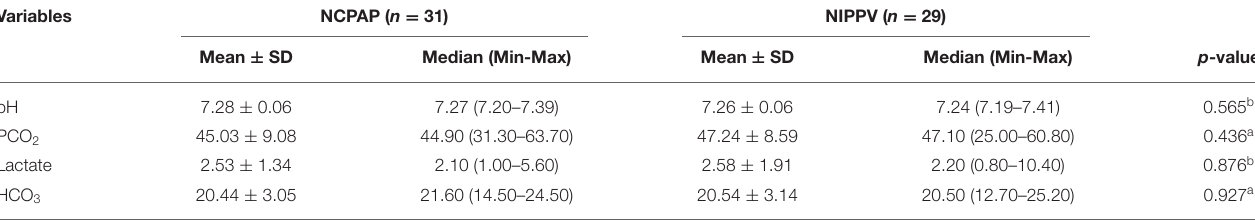
TABLE 2 | Initial blood gas parameters at